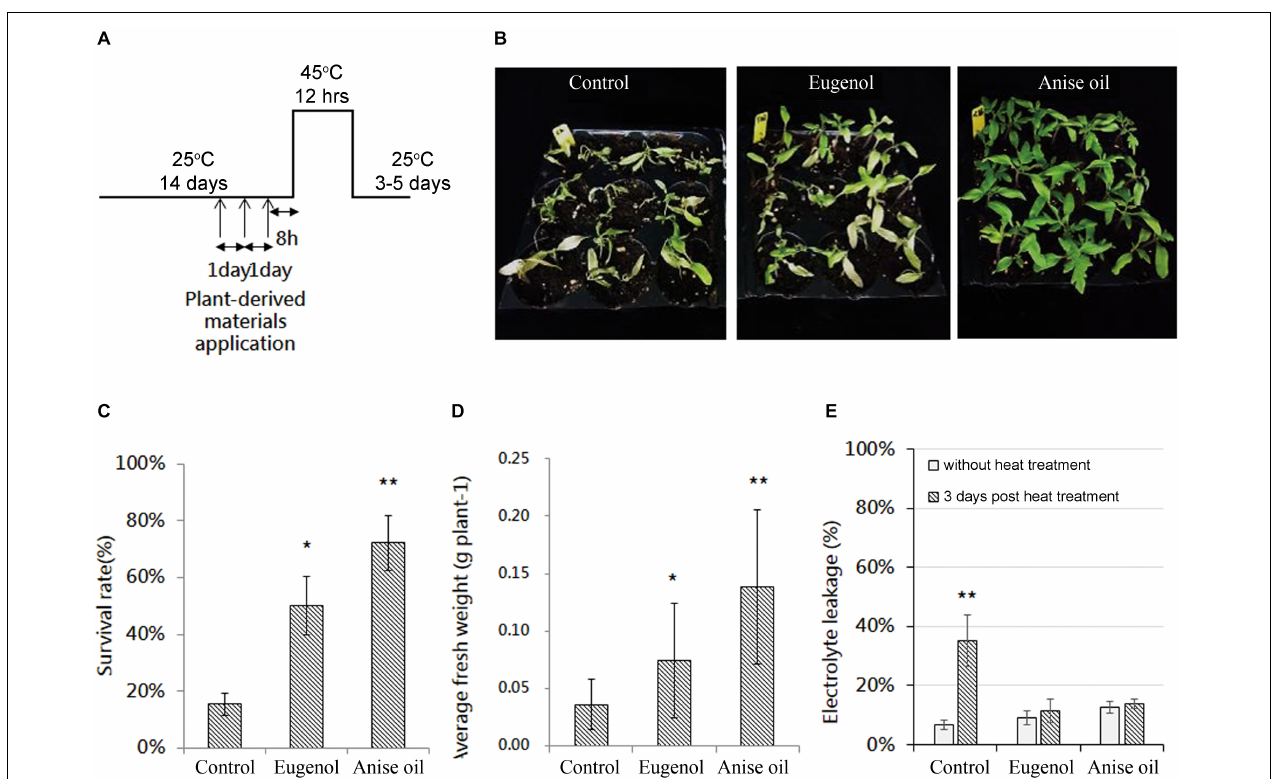
FIGURE 1 | Effects of the pre-application of eugenol and anise oil on the thermotolerance of tomato plants. (A) Schedule for the application of plant-derived materials, heat treatment, and harvest. Phenotypes were analyzed at the indicated time points. The concentrations of the plant-derived materials, eugenol and anise oil, were 200 µ g mL − 1 . After an exposure to heat stress and a 5-day recovery period, tomato plants with different treatments were photographed (B) . The survival rates (C) and fresh weights (D) of these plants were also recorded based on 18 technical replicates in three independent experiments. Additionally, the relative leakage of leaf electrolytes (E) was measured after a 3-day recovery period. Bars represent the mean of three experiments ( ± standard error of the mean). Significant differences between control and anise oil- or eugenol-treated plants were assessed with Student’s t -test ( ∗ P < 0.05; ∗∗ P <